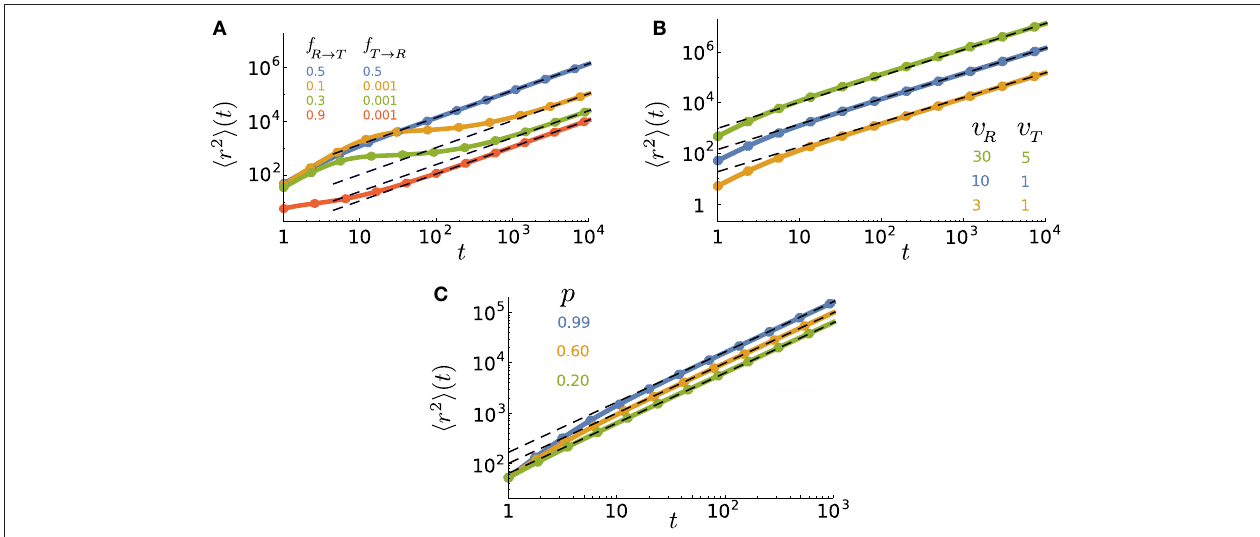
FIGURE 2 | Time evolution of the MSD for various (A) transition probabilities, (B) speeds, and (C) persistencies. The parameter values (unless varied) are taken to be = 0.5, f = 0.5, and P R 0 = 0.5. The lines are obtained from the inverse z-transform of Equation (10) and symbols denote simulation p = 0.9, v R = 10, v T = 1, 1 t = 1, f R → T T → R results. The dashed lines represent the asymptotic diffusion regime.